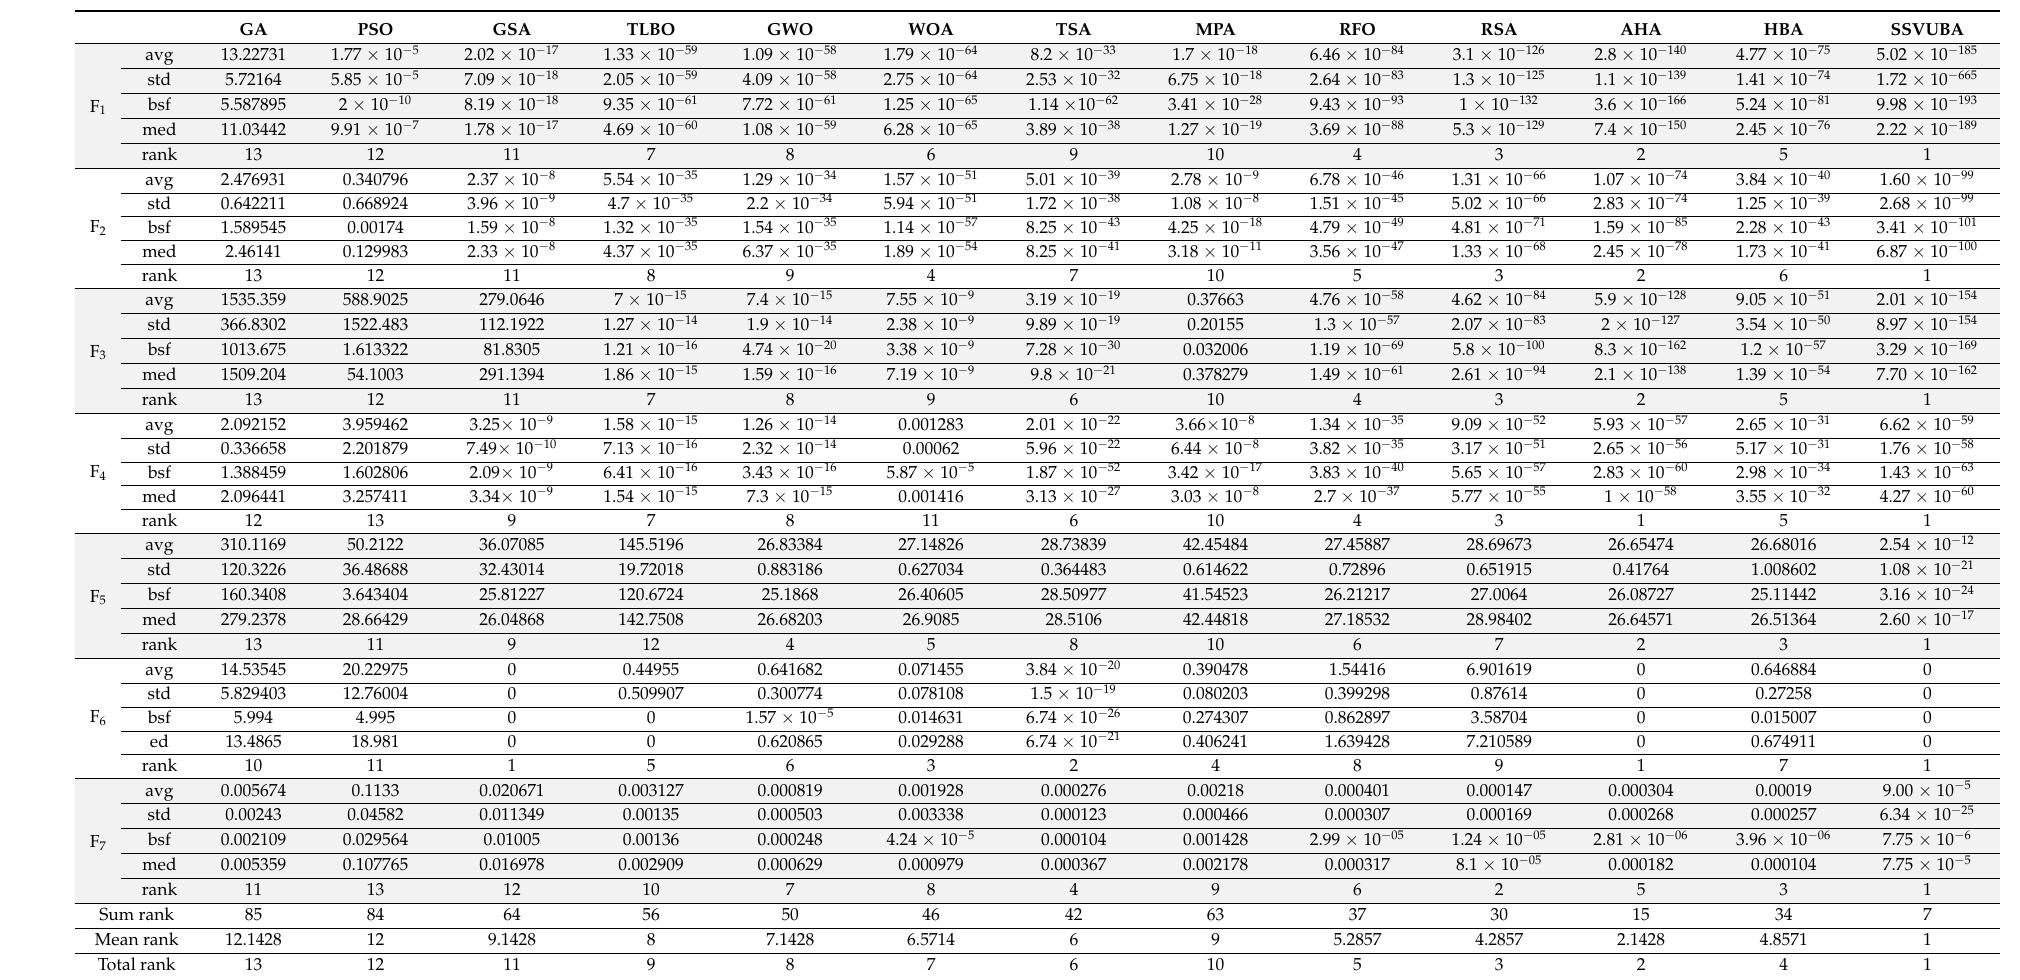
Table 2. Assessment results of unimodal